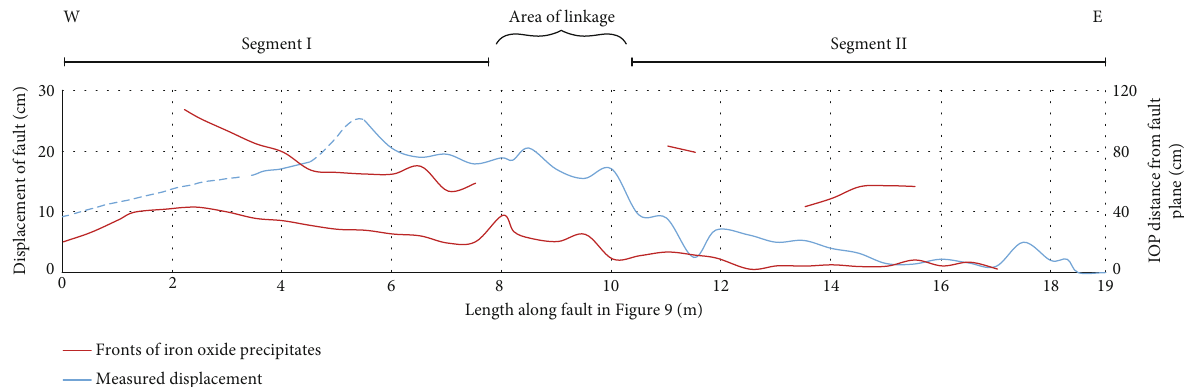
Figure 10: The graph shows the extent of the fronts of iron oxide precipitates (in red) vs. the length of the fault, as well as the length- displacement relationship (in blue) of the studied network in Figure 9. The prominent fronts of iron oxide precipitates exhibit an overall widening from E to W, tapering towards the E and terminating along what is segment II in Figure 9. This coincides with the eastward decrease of